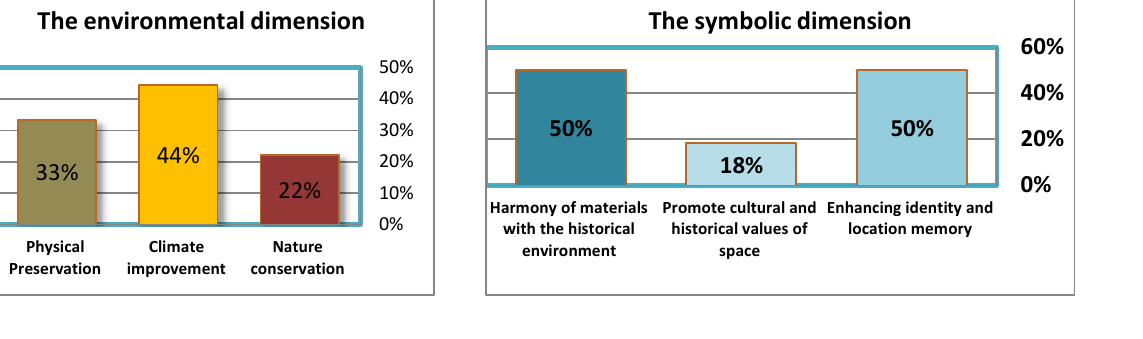
Fig. 17. Rate of achieving symbolic dimension indicators for landscape activation (by the